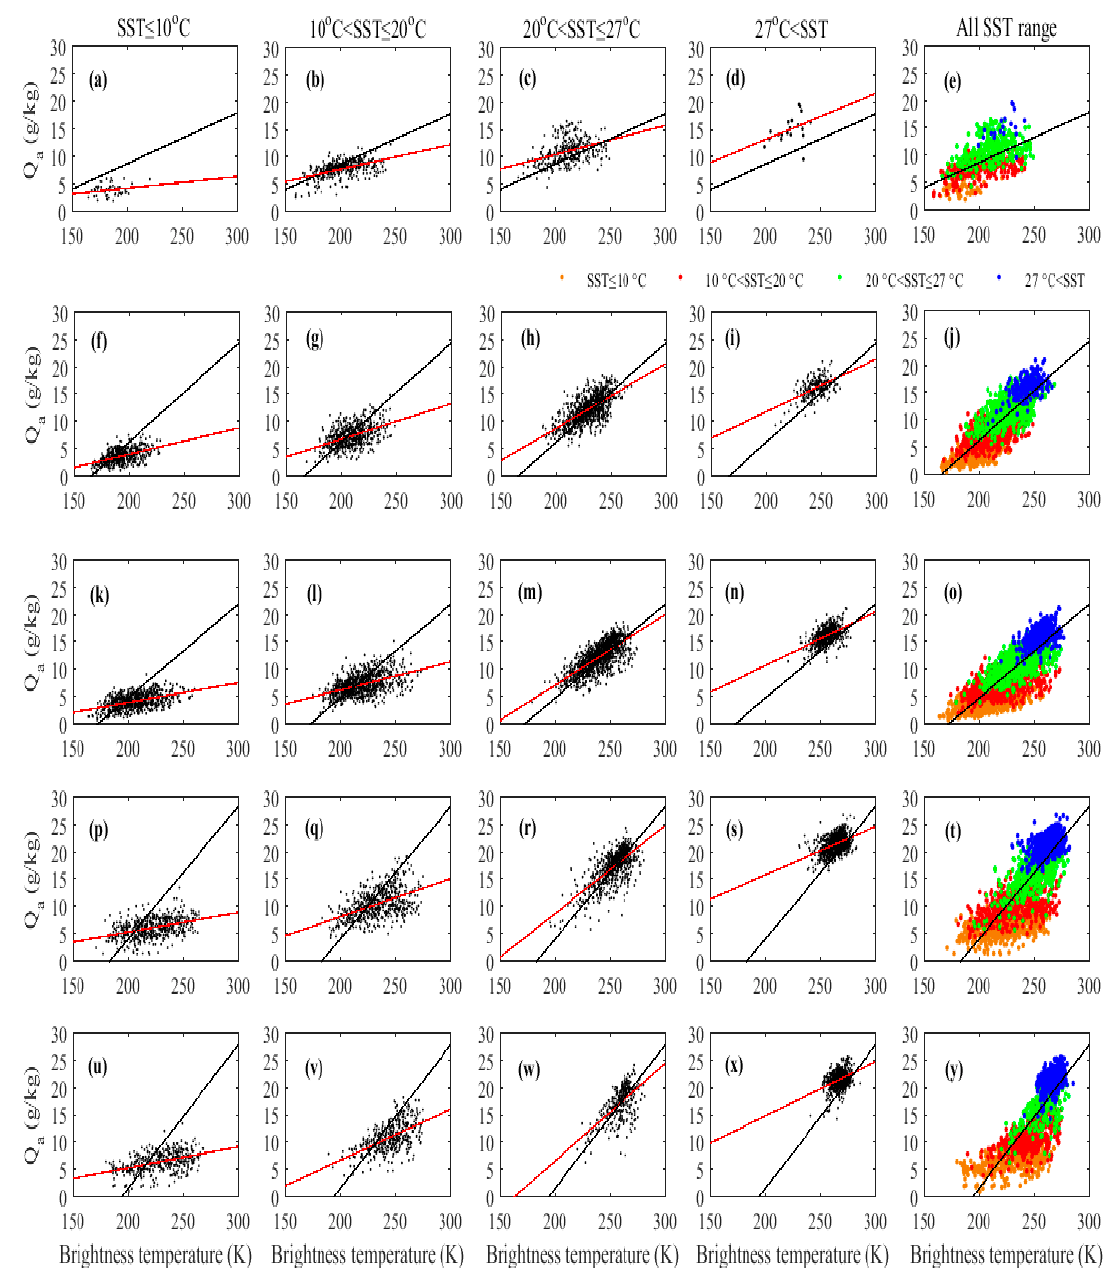
Figure 6. The relationship between T B ,89 H , Q a , and SST. ( a – e ) For H v ≤ 1300 m; ( f – j ) for 1300 m < H v ≤ 1800 m; ( k – o ) for 1800 m < H v ≤ 2300 m; ( p – t ) for 2300 m < H v ≤ 2800 m; and ( u – y ) for H v > 2800 m. Each subfigure shows a linear regression black line calculated using all data of the same H v range; the red line was calculated using the corresponding SST range data.